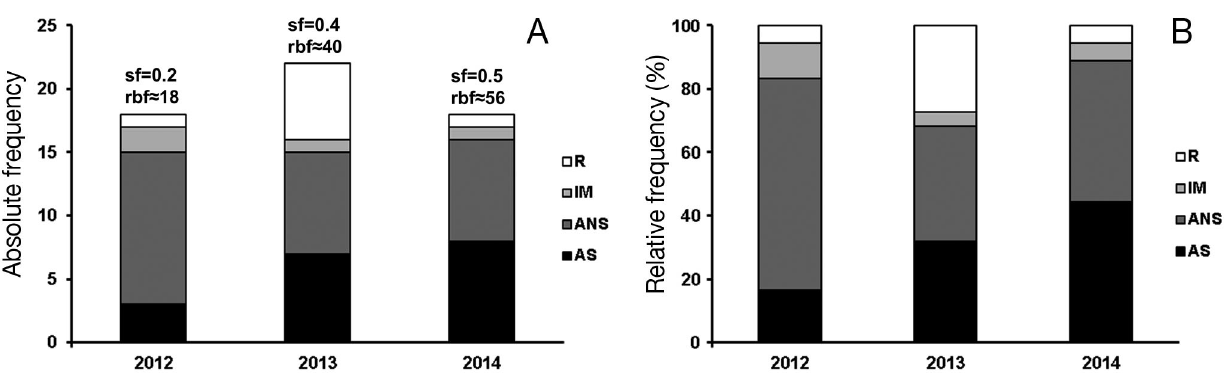
Fig. 4. (A) Absolute and (B) relative frequencies of the maturity stages found in Atlantic bluefin tuna Thunnus thynnus females sampled in 2012, 2013 and 2014. ANS: active nonspawning; AS: active spawning; IM: inactive mature; R: resting; rbf: relative batch fecundity (eggs g −1 ); sf: spawning